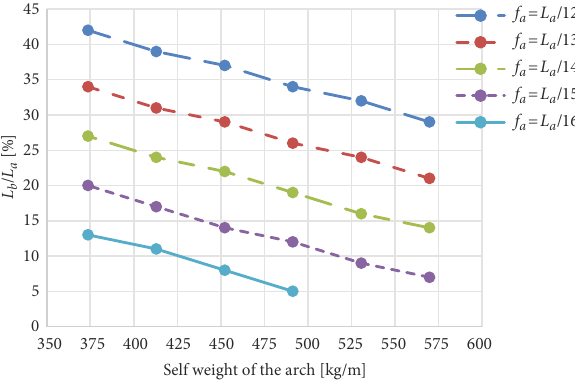
Figure 6. The dependence of the length of the loaded part of the arch on the self-weight and the rising part of the arch when the horizontal bearing reaction of the stress ribbon structure is equal to the thrust of the arch ( H v = H a ). L a – arch span, f a – rising part of the arch, L b – the length of the intermediate support (saddle) of stress ribbon